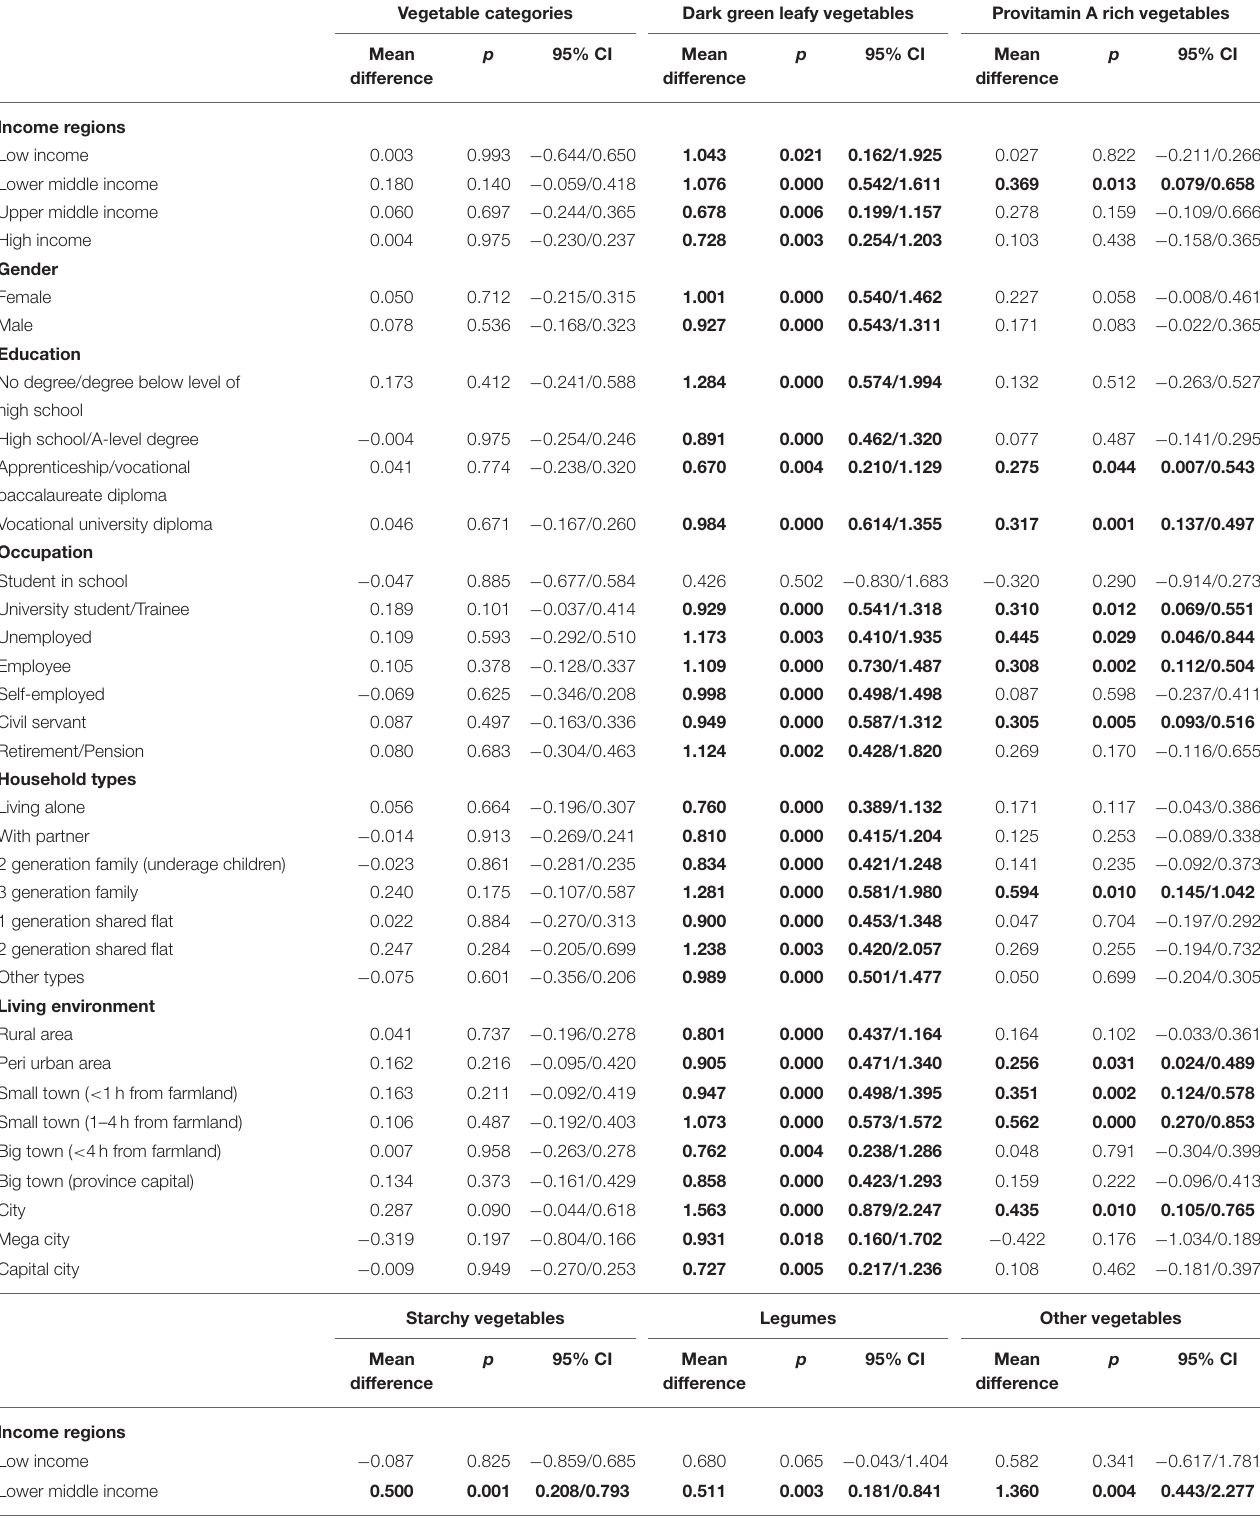
TABLE 4 | Results of Poisson regressions for changes since the onset of the pandemic in the diversity of vegetable categories, dark green leafy vegetables, and provitamin A rich vegetables. Vegetable